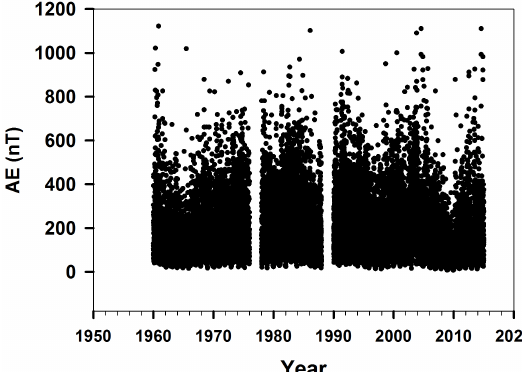
Figure 1. The AE time series from 1960 to